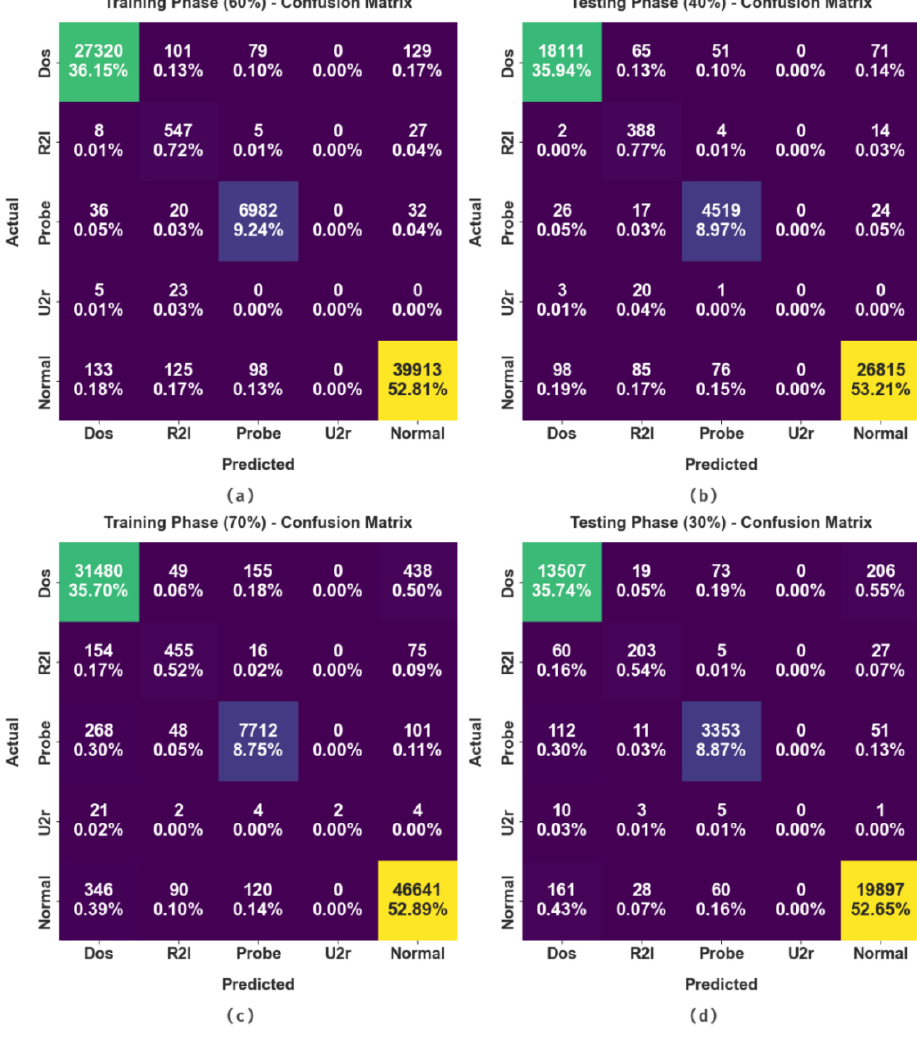
Figure 3. Confusion matrices of FSHDBN-CID approach ( a ) 60% of TR dataset, ( b ) 40% of TS dataset ( c ) 70% of TR dataset, and ( d ) 30% of TS dataset.